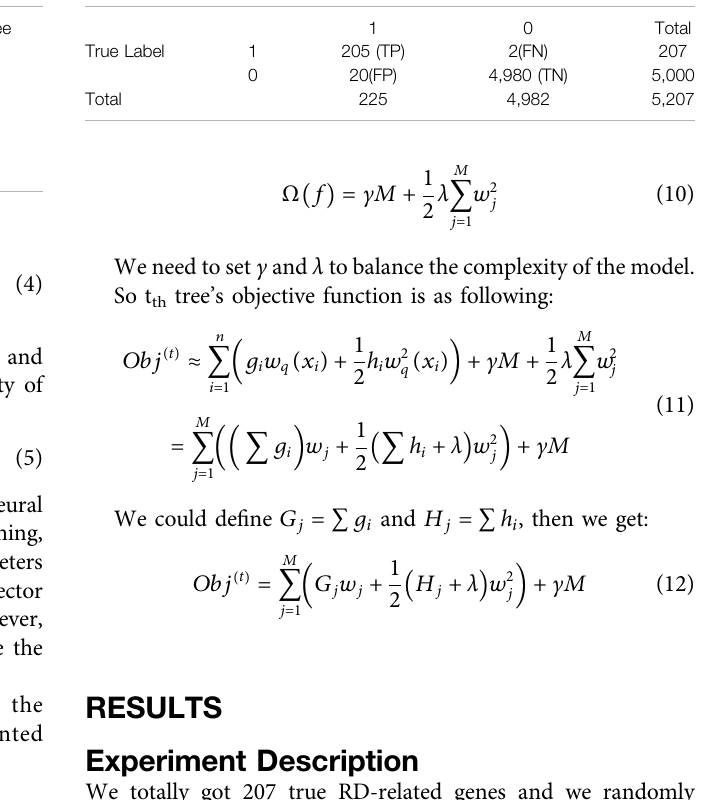
TABLE 2 | The parameters of the Xgboost. Setting items